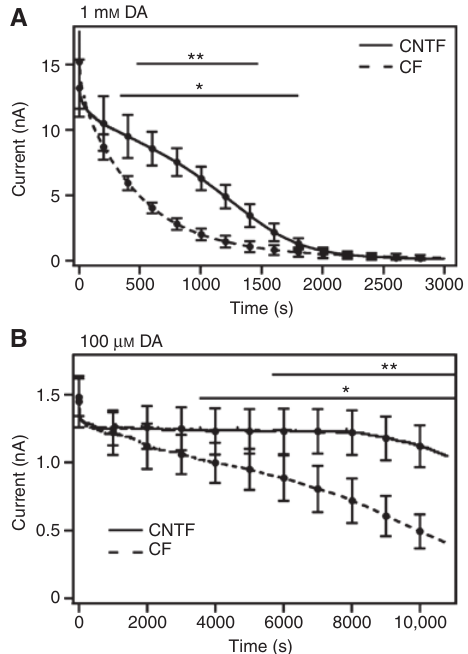
Figure 1: Amperometric currents for 1 mm dopamine (A) and 100 μ m dopamine (B) obtained at 0.8 V versus Ag|AgCl with a carbon nanotube fibre microelectrode (solid line) and a carbon fibre microelectrode (dashed line) in phosphate-buffered saline (pH 7.4). Mean ± SD (n = 4–7). The results were compared using Student’s t-test, *p < 0.05, **p < 0.01. Reproduced with permission from Harreither et al.